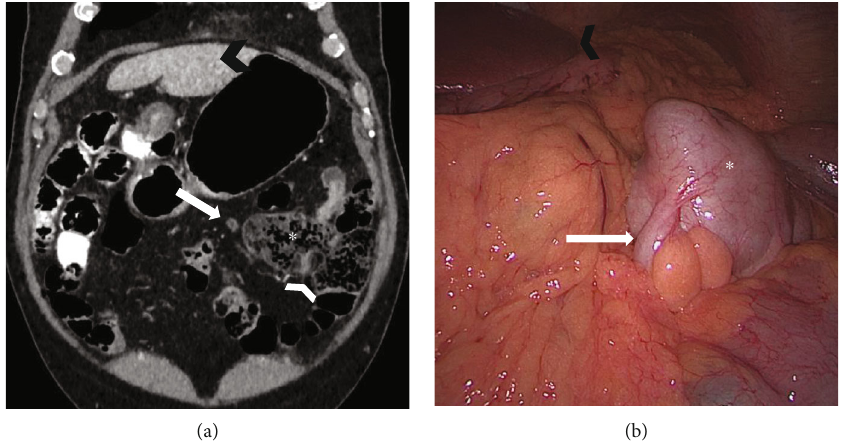
Figure 2: (a) Coronal reformatted contrast-enhanced CT image and (b) laparoscopic view demonstrate malrotation of the bowel with the ileocaecal valve (white arrowhead), the caecum (asterisk), and the normal appendix (white arrow) placed on the left side of the abdomen. Left hepatic lobe: black arrowhead.